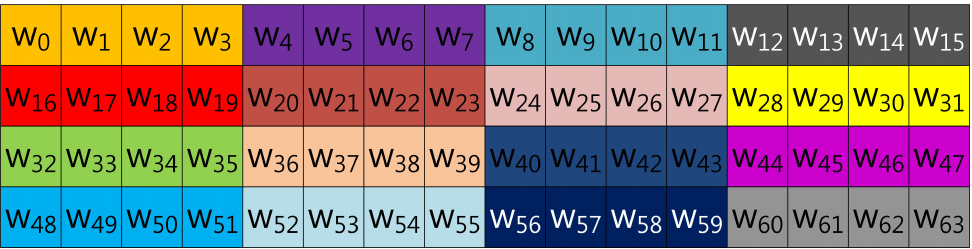
Figure 3. Look-up table structure of Mohamed, Hashim and Hutter’s method in a block form for 4NAF.